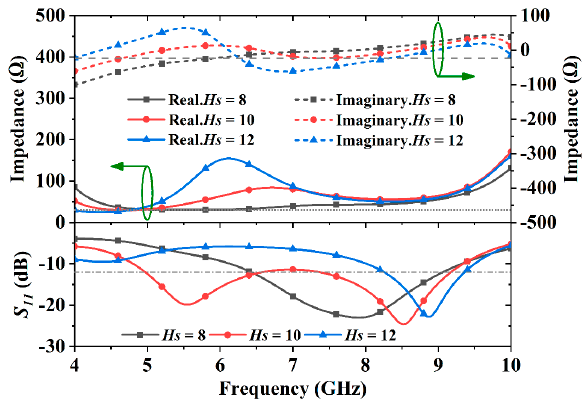
Figure 5. The impedance and S 11 for different values of Hs .